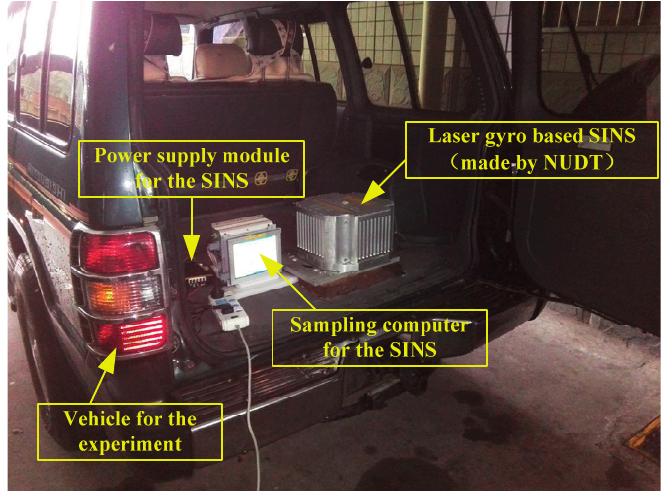
Figure 9. The vehicular experiment scene and the related